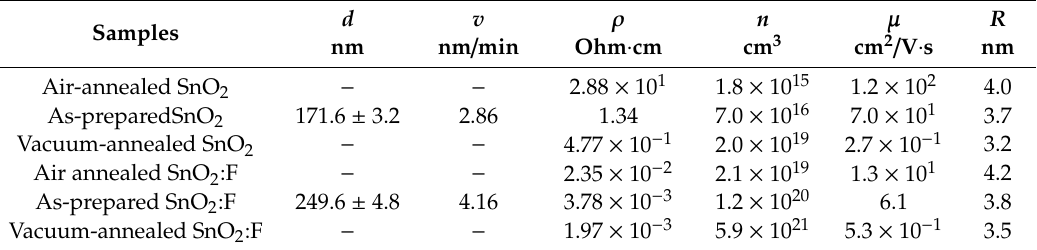
Table 1. Electrical parameters of as-prepared and annealed SnO 2 -based